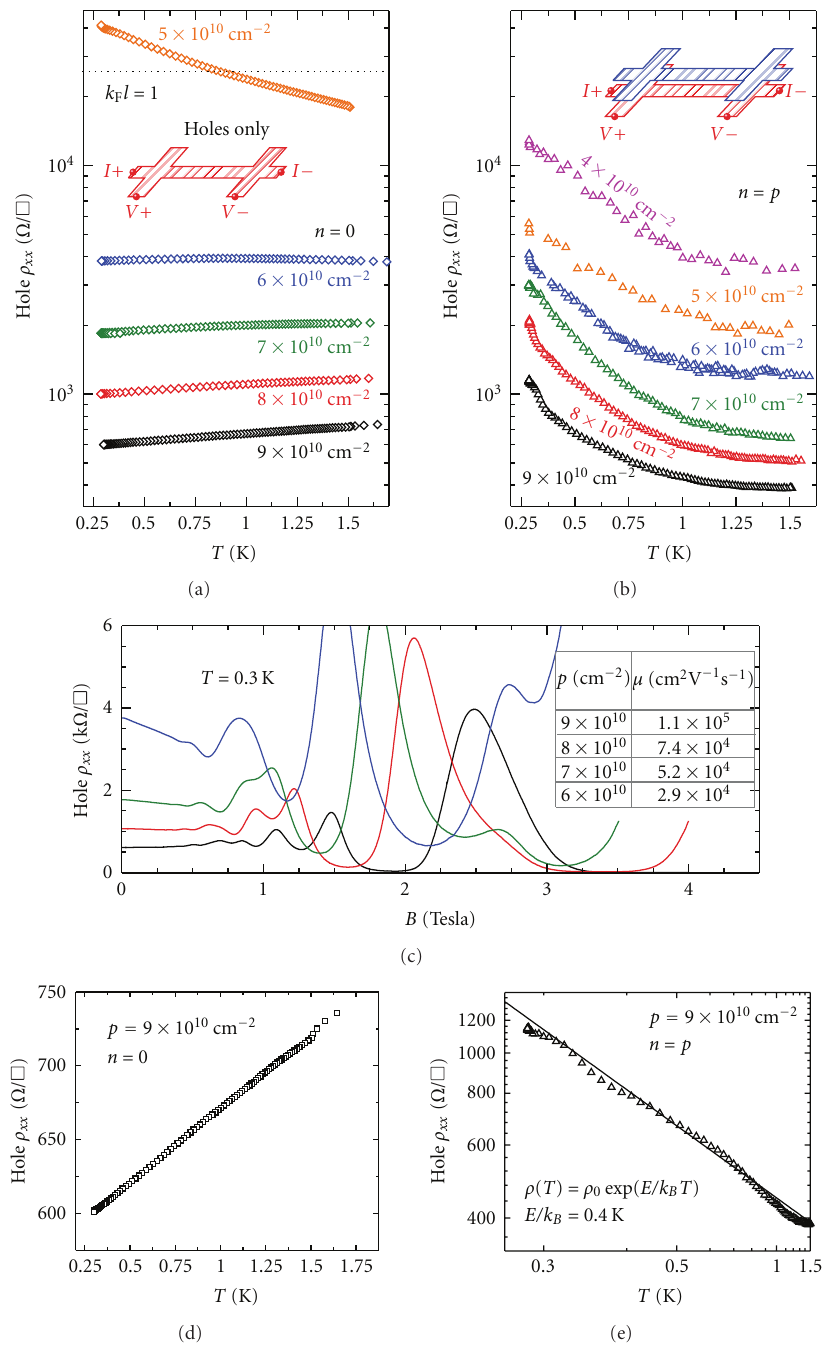
Figure 18: Resistivity of hole layer versus temperature for p = 5,6,7,8,9 × 10 10 cm − 2 at B = 0, (a) without electrons ( n = 0) and (b) with electrons ( n = p ). (c) Magnetoresistance ρ xx ( B ) of hole layer for p = 6,7,8,9 × 10 10 cm − 2 with no electrons present ( n = 0), at T = 0 . 3 K. (d) “Metallic” hole layer ρ xx ( T ) for p = 9 × 10 10 cm − 2 , n = 0. (e) Arrhenius plot (ln( ρ ) against 1 /T ) for “insulating” hole layer ρ xx ( T ) with n = p = 9 × 10 10 cm − 2 , showing good fit to an exponential rise. (Device: B138/C4-2-10nm Barrier).